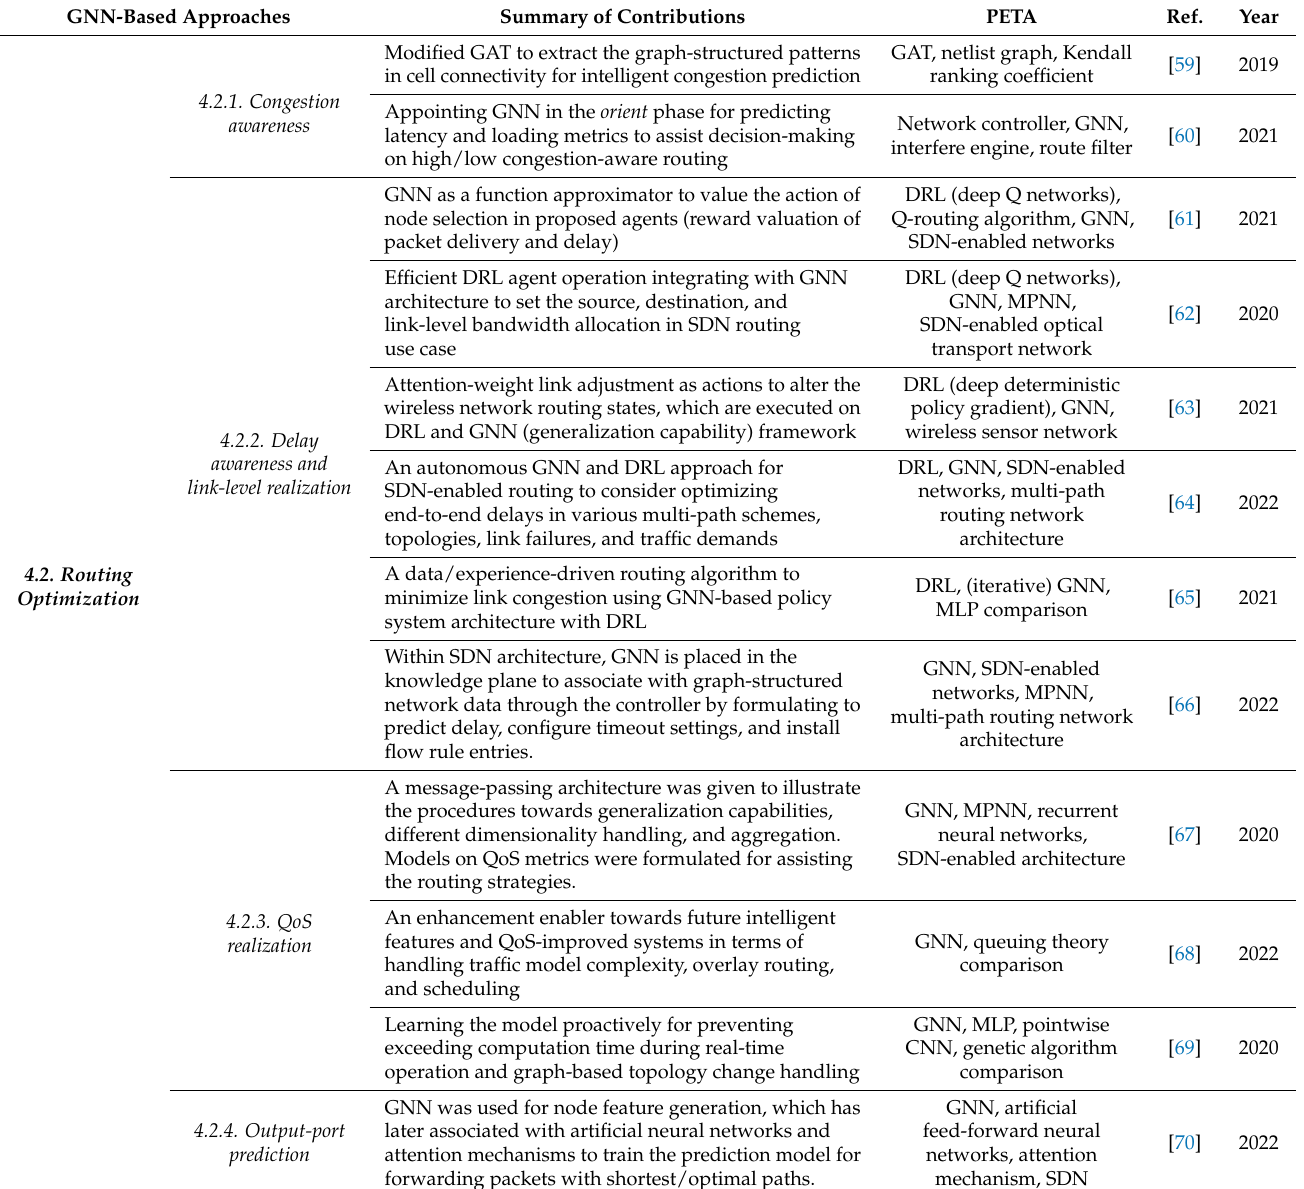
Table 4. Summary of Selected Works in GNN-Based Routing